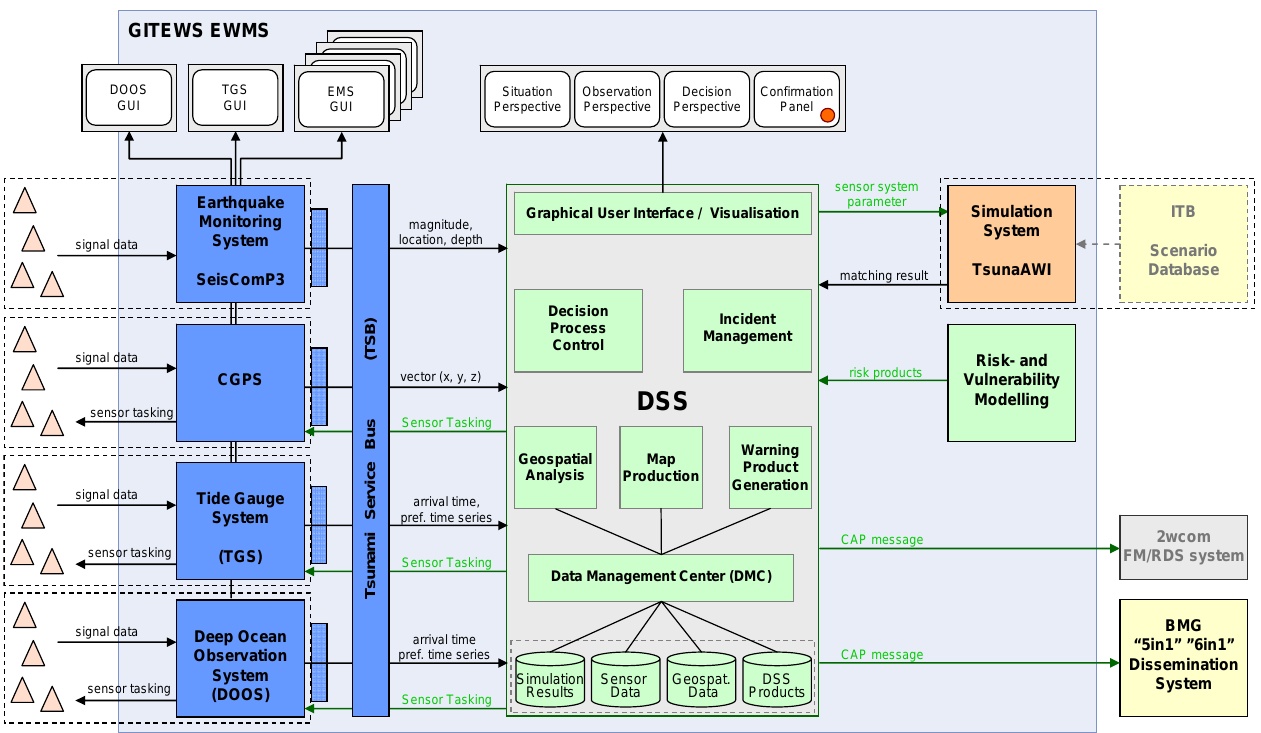
Fig. 1. The architectural view of the Early Warning and Mitigation System (EWMS). Bright box in the center: DSS Data Management Center . Above it: DSS Graphical User Interface (aka: DSS Client ). The Sensor System Integration with the respective GUIs, Simulation System using tsunami scenarios calculated by the TsunAWI tsunami modelling system, Risk and Vulnerability Modelling and Dissemination Systems are external systems and models. DSS uses OGC (Opengeospatial Consortium) standards internally and externally to implement the connecting services between individual components.